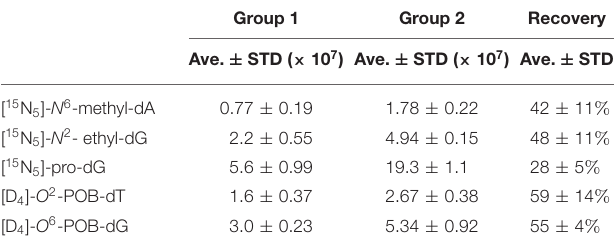
TABLE 2 | Assessment of analyte recoveries: Group 1 samples spiked with internal standards (100 fmol) at the beginning of the enzymatic digestion. Group 2 samples spiked with internal standards (100 fmol) at the end of the sample